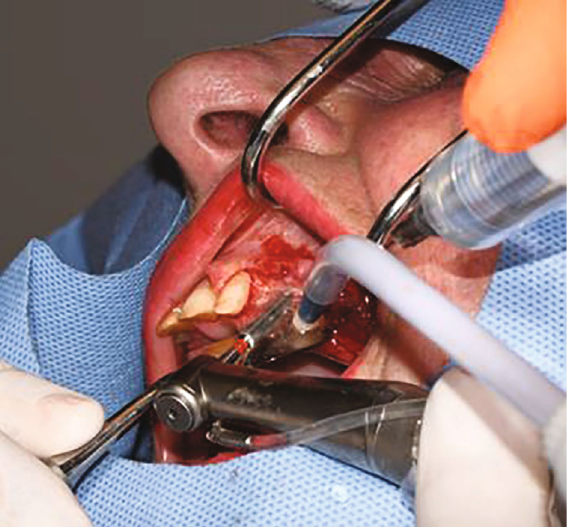
Figure 6: Gradual drilling with additional saline irrigation/cooling.